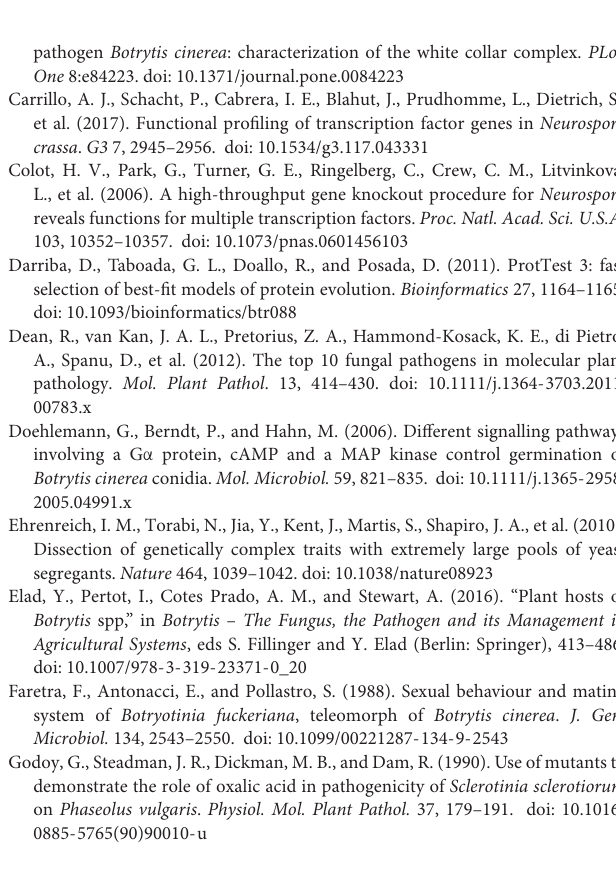
Supplementary Figure 1 | Evaluation of aggressiveness in V. vinifera leaves of the B448 x B371 cross progeny. The bars indicate mean values from three independent experiments. Standard deviations are shown. Non-wounded inoculated leaves were incubated at 22 ◦ C with a 16 h photoperiod for 96 h. Supplementary Table 1 | Oligonucleotides used in this